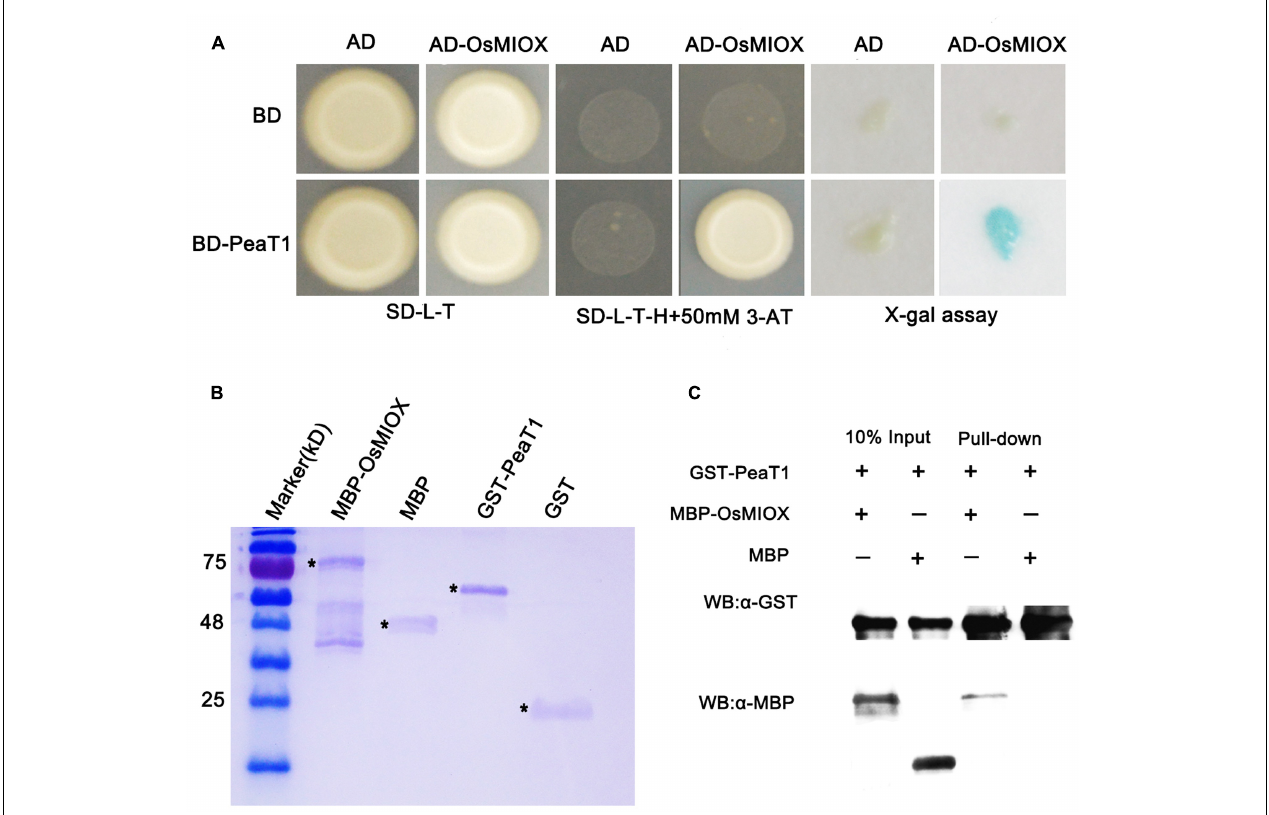
FIGURE 3 | PeaT1 interacts with OsMIOX. (A) Results of a yeast two-hybrid assay involving BD-PeaT1 and AD-OsMIOX. The transformed yeast cells were plated on SD/-Leu/-Trp medium (left) and SD/-Leu/-Trp/-His medium supplemented with 50 mM 3-AT (middle). The results of the X-gal assay are also provided (right). (B) Purified proteins stained with Coomassie Brilliant Blue. (C) A solution consisting of PeaT1-GST bound to the GST-binding resin was incubated with an equal volume of cell lysate containing OsMIOX-MBP or MBP. The binding of OsMIOX-MBP or MBP to the GST-binding resin before (Input) and after (Pull-down) washes was examined in a western blot involving the anti-MBP antibody. The same protein gel was used for a western blot involving the anti-GST antibody to verify that equal amounts of GST-PeaT1 were present in all protein mixtures. ∗ Represents the target protein